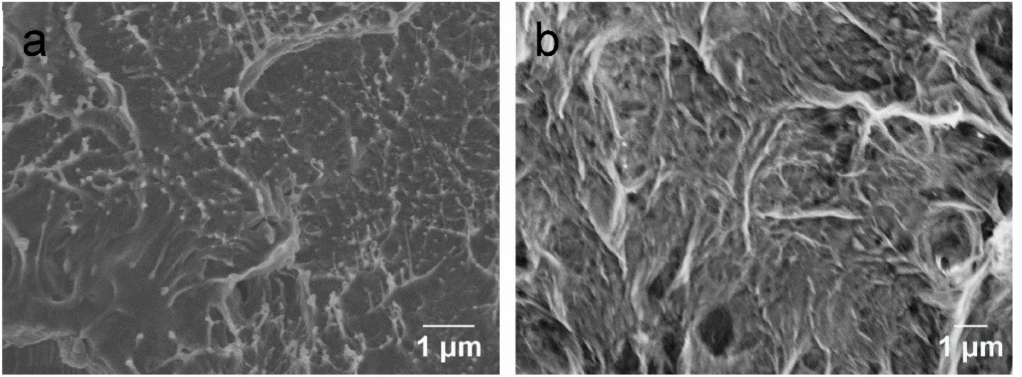
Figure 11. Comparison of fractography of consolidated nanocomposites ( a ) before and ( b ) after cyclic loading for 3000